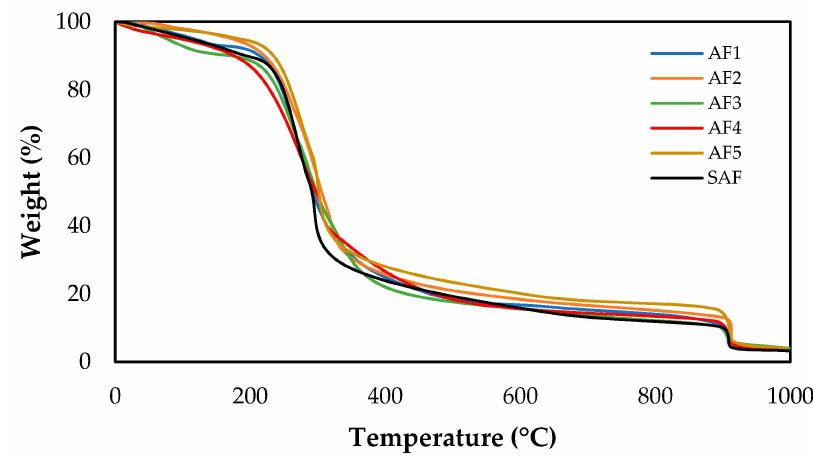
Figure 4. Thermogravimetric Analysis of AFs. (SAF: standard adhesive formulation; AF1: Thymus ble- icherianus ; AF2: Thymus capitates ; AF3: Thymus satureioides ; AF4: Thymus vulgaris ; AF5: Thymus zygis